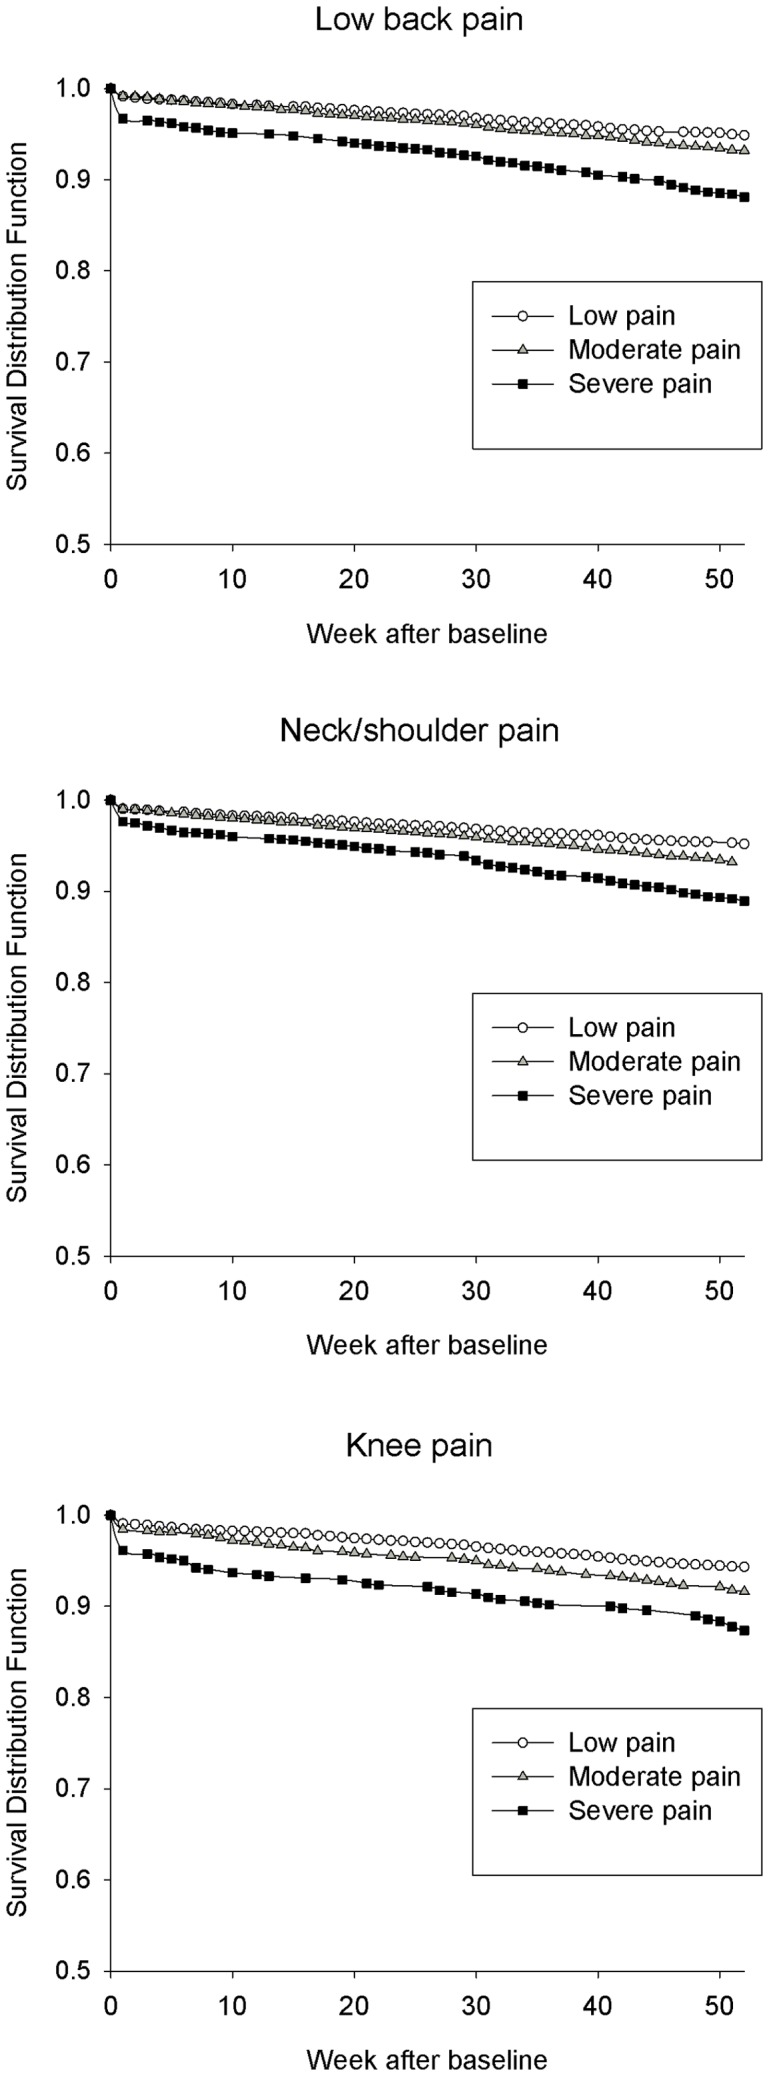
Visual representation of the hazards (Kaplan-Meier curves) at 0–52 weeks from baseline for low back pain, neck/shoulder pain and knee pain, respectively.The Y-axis represents the proportion of female healthcare workers not having LTSA. Pain intensity is stratified into low (0–2), medium (3–5) and severe (>5) pain on a scale of 0–10.